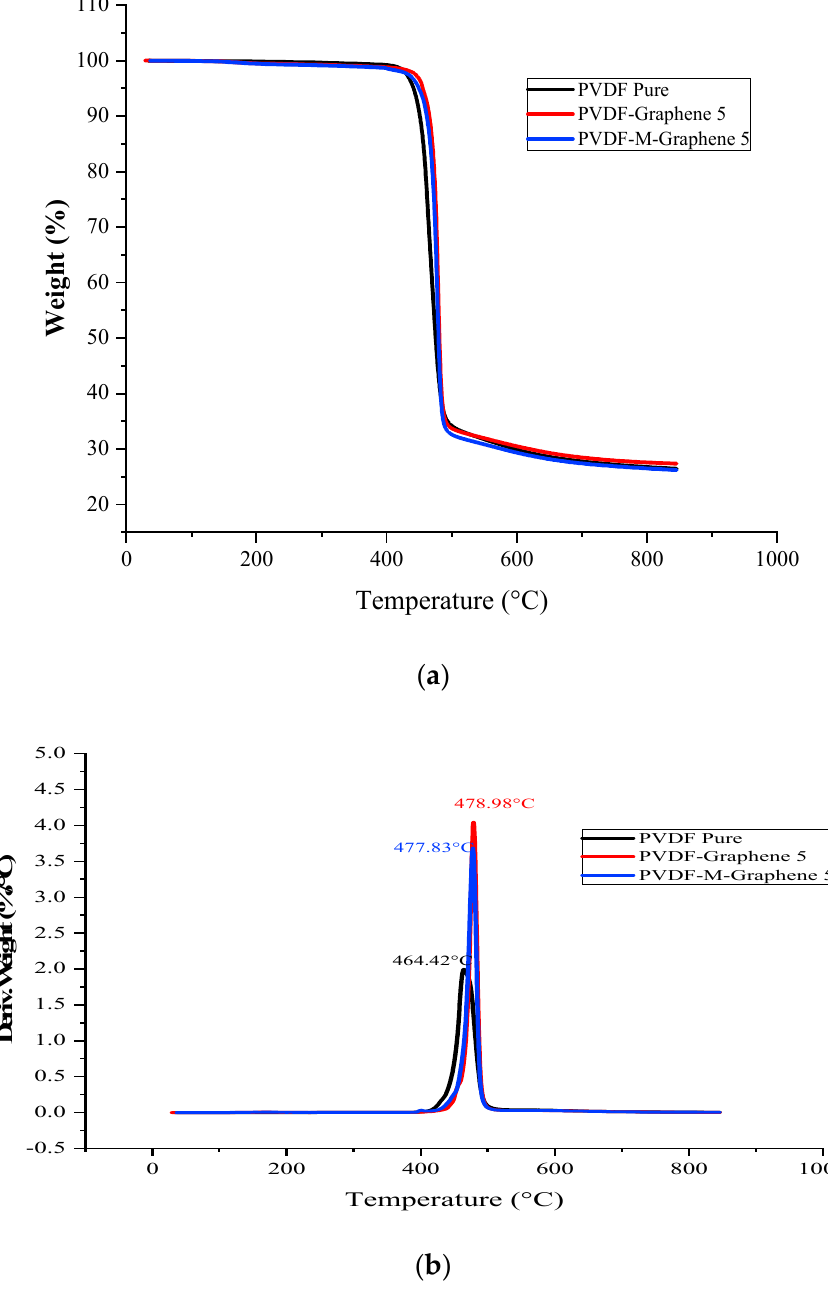
Figure 7. ( a ) TGA graphs and ( b ) DTG graphs of the GNF − PVDF nanocomposites.